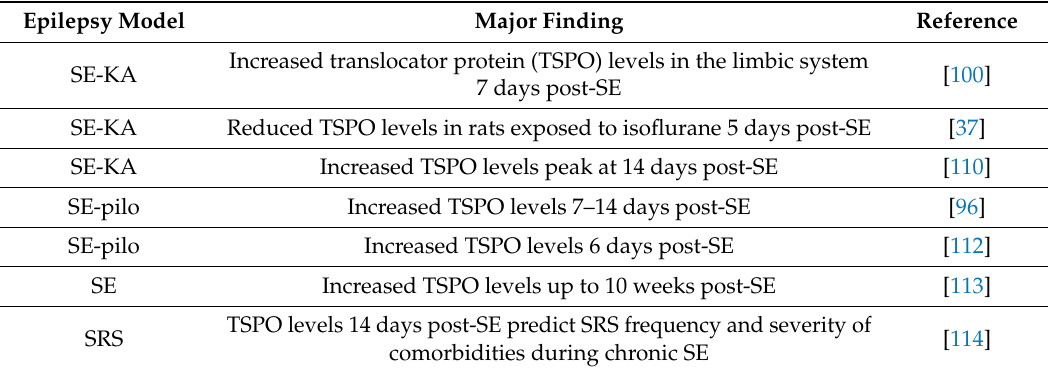
Table 10. List of PET molecular imaging studies for brain inflammation and potential biomarkers for